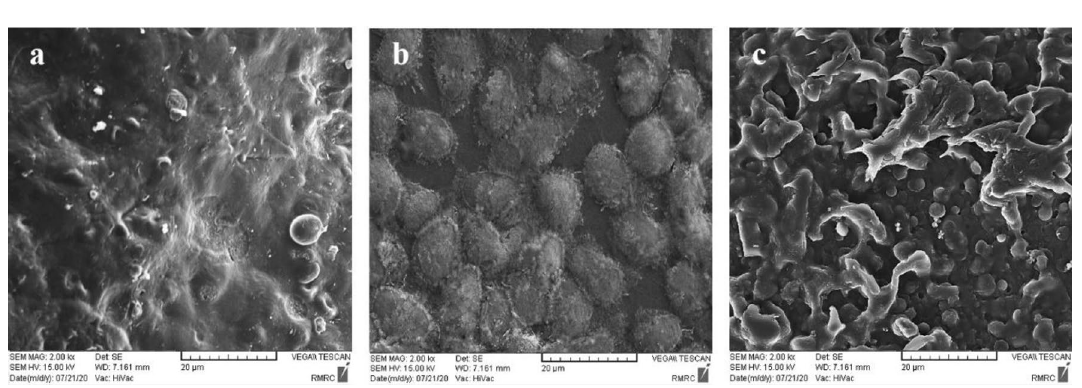
Figure 9. Representative SEM images of: ( a ) cell-free CSNP/PCL 50/25 membrane, ( b ) HCECs cultured on culture plate as control for 5 days, ( c ) HCECs cultured on CSNP/PCL 50/25 for 5